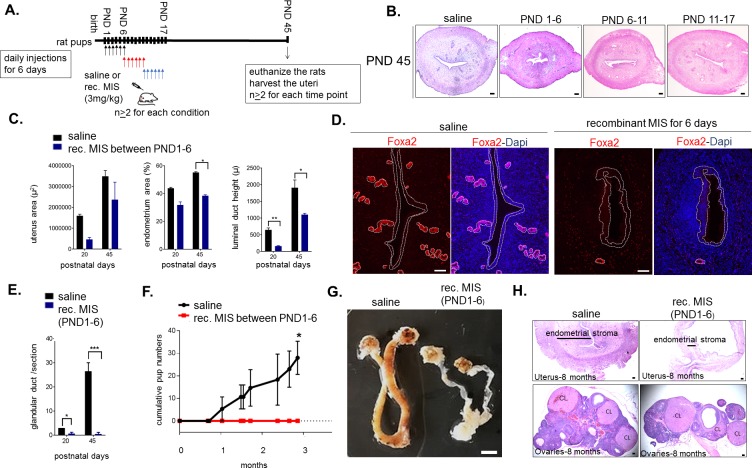
Temporary treatment with MIS during only for the first 6 days of uterine developmental is sufficient to cause complete infertility in adulthood.(A) Rat pups were injected daily with recombinant MIS protein (3 mg/kg) (MIS), or saline control (CTL), from PND1-6, PND6-11, or PND11-17. (B) Uterine morphology was analyzed on PND45 with H and E stained transverse sections (n > 2). Scale bars are 100 µm. (C) Total uterus area, the percentage of the endometrial area, and the luminal duct height in CTL and MIS-treated (from PND1-6) were compared at PND20 and 45. (D) Foxa2 immunofluorescence (red) on CTL and MIS-treated uteri (from PND1-6) was analyzed at PND20. Scale bars = 50 µm. (for C and D: for PND20, n = 2 for control, n = 3 for MIS; for PND45, n = 2 both for control and MIS, mean ± SEM, unpaired Student’s t test * (p<0.05), ** (p<0.01)). (E) Endometrial gland counts were compared in CTL and MIS-treated uteri (from PND1-6) at PND20 and 45 from H and E sections. (F) Cumulative pups per females in 3 months continuous mating studies of the control and MIS-treated rat uteri. (n = 3 both for the control and the treated, unpaired Student’s t test mean ± SEM, * (p<0.05), *** (p<0.001)). (G) Gross morphology of the CTL and the MIS-treated (PND1-6) uteri at 8 months of age. Scale bar = 0.5 cm. (H) Uterine transverse sections (top) and ovaries (bottom) of the control and MIS-treated rats at 8 months of age. CL stands for corpus luteum. Scale bars = 100 µm.10.7554/eLife.46349.028Figure 5—source data 1.Data, number of replicates and p values of significance between the control and recombinant MIS-treated uterine samples for histomorphological analysis.Related to Figure 5B and C.